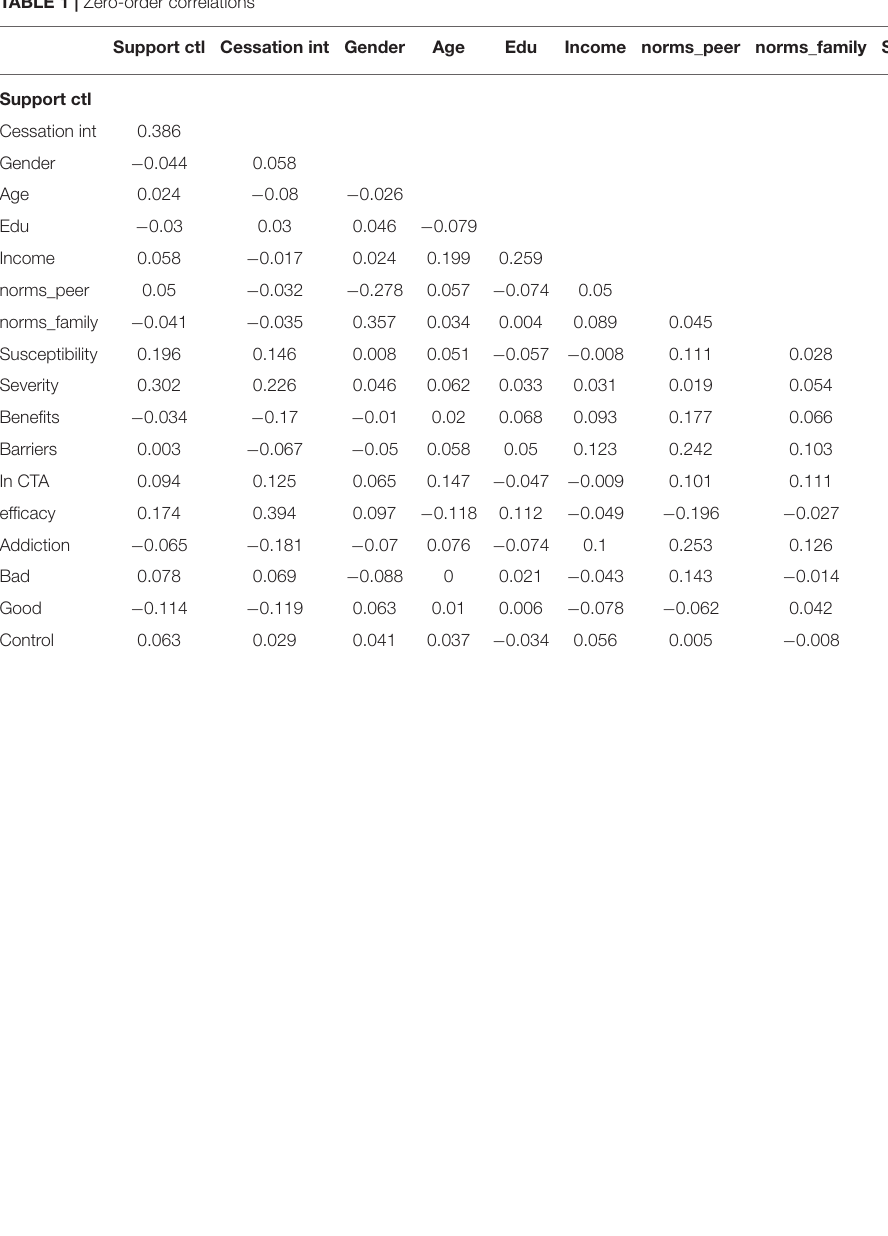
TABLE 1 | Zero-order